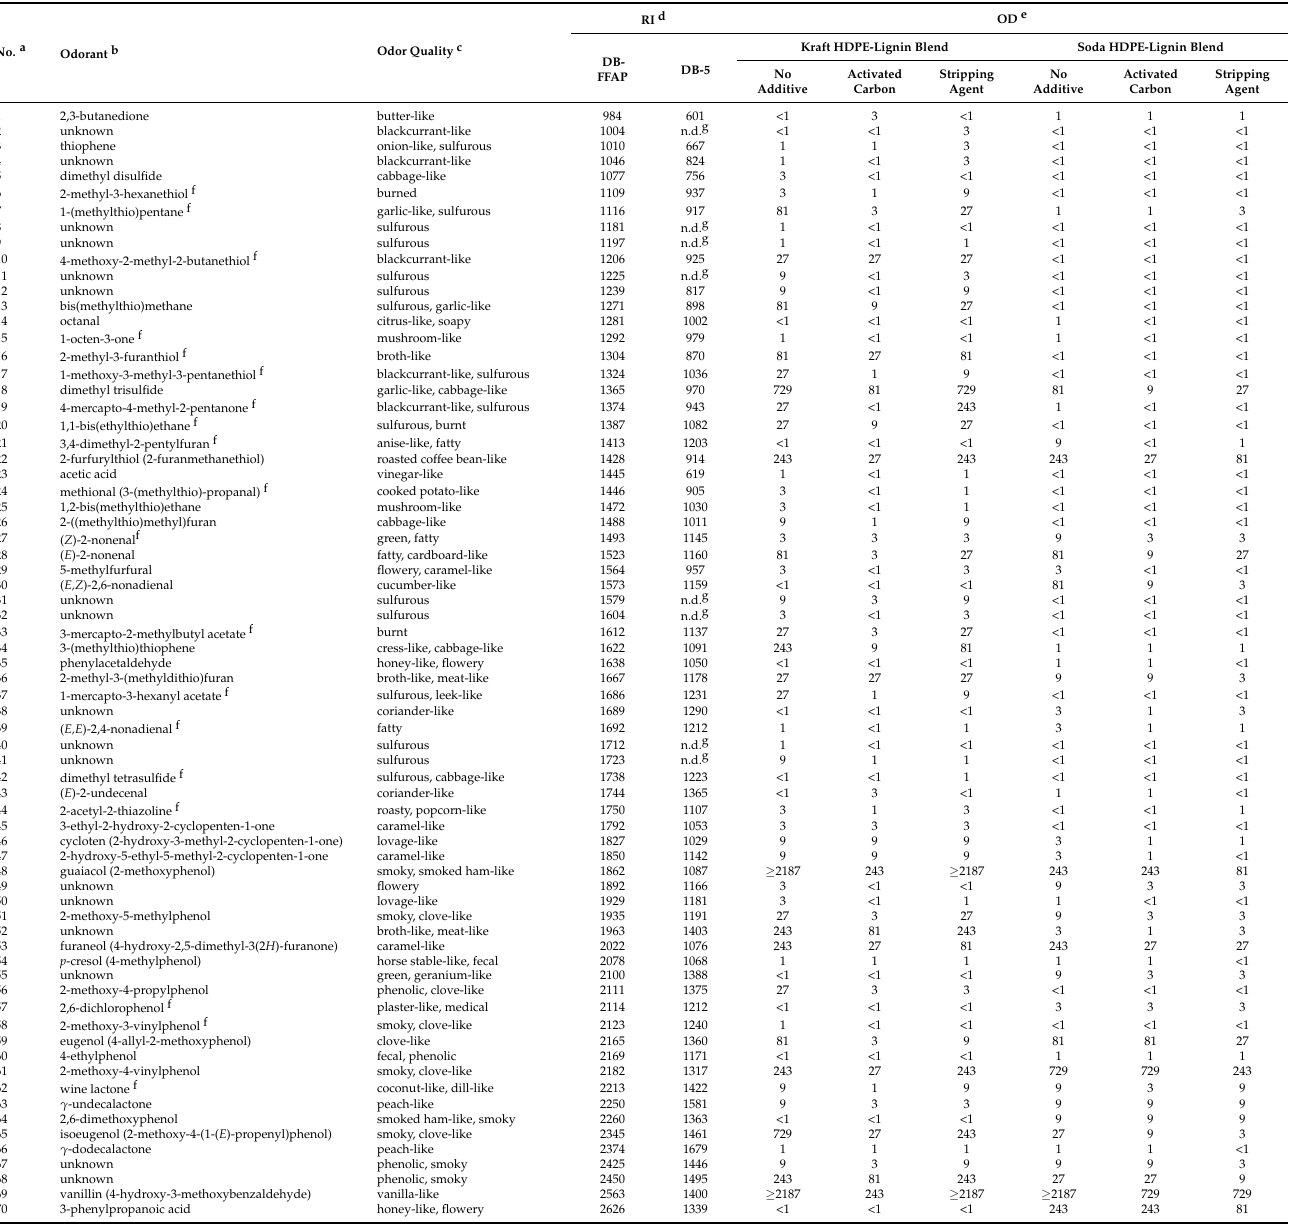
Table 3. Detected odorants in untreated and treated (activated carbon/stripping agent) kraft and soda HDPE-lignin blends and respective OD-factors determined via